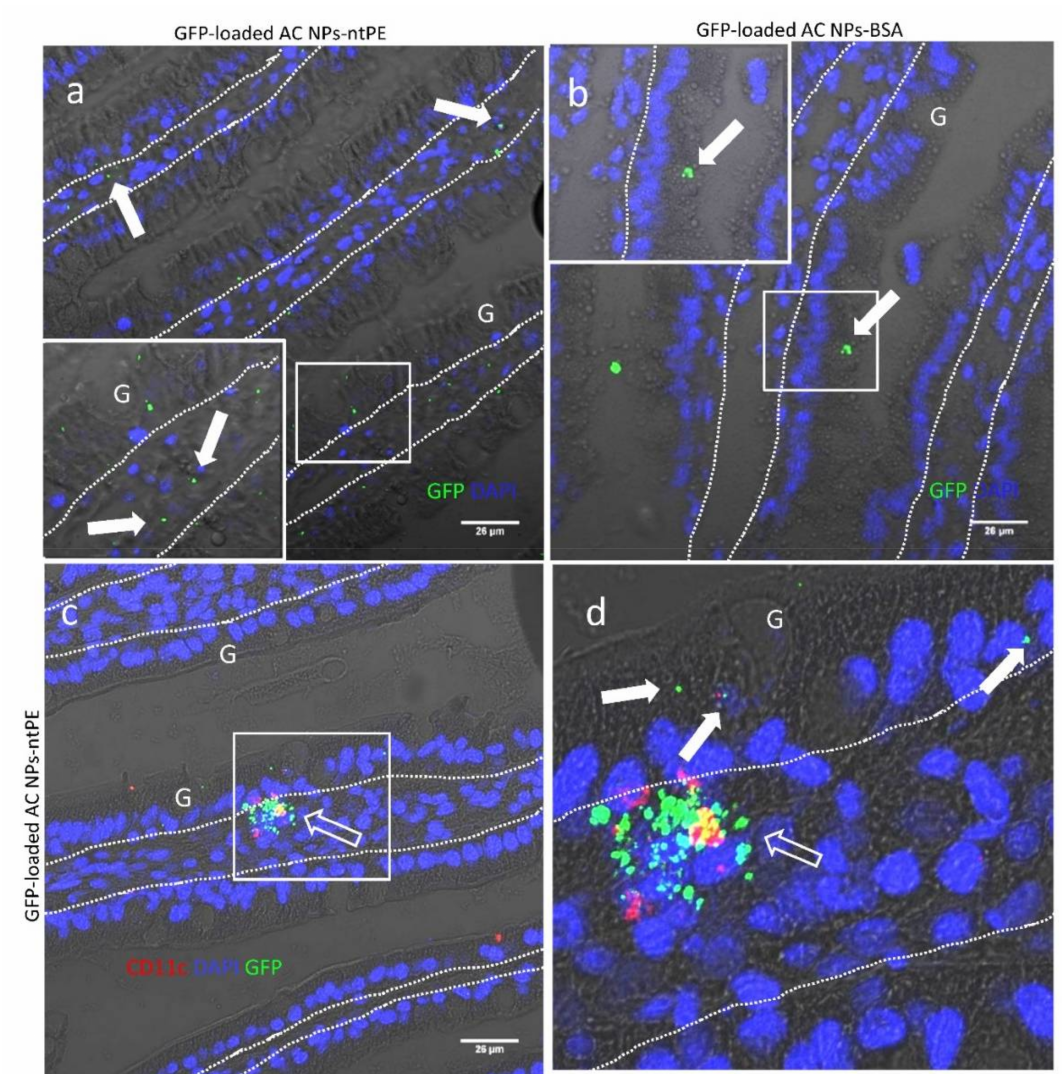
Figure 8. Representative confocal fluorescence images of intestinal villi following intra-luminal injection (ILI) into rat jejunum of test articles. ( a ) Green fluorescent protein (GFP)-loaded alginate/chitosan (AC NPs) coupled to a non-toxic version of Pseudomonas aeruginosa exotoxin A (AC NPs-ntPE-GFP) or ( b ) coupled to bovine serum albumin (AC NPs-BSA- GFP) at 30 min post-ILI. ( c , d ) AC NPs-ntPE in the villi co-localising with CD 11c + cells (( d ) is a magnification of a specific localtion identified ( c )). GFP localizations = solid arrows. CD11c localizations = open arrows. Mucin-filled goblet cell = G. Lamina propria-epithelium demarcation = dashed line. Nuclei were stained blue with DAPI. Scale bar = 26 µ